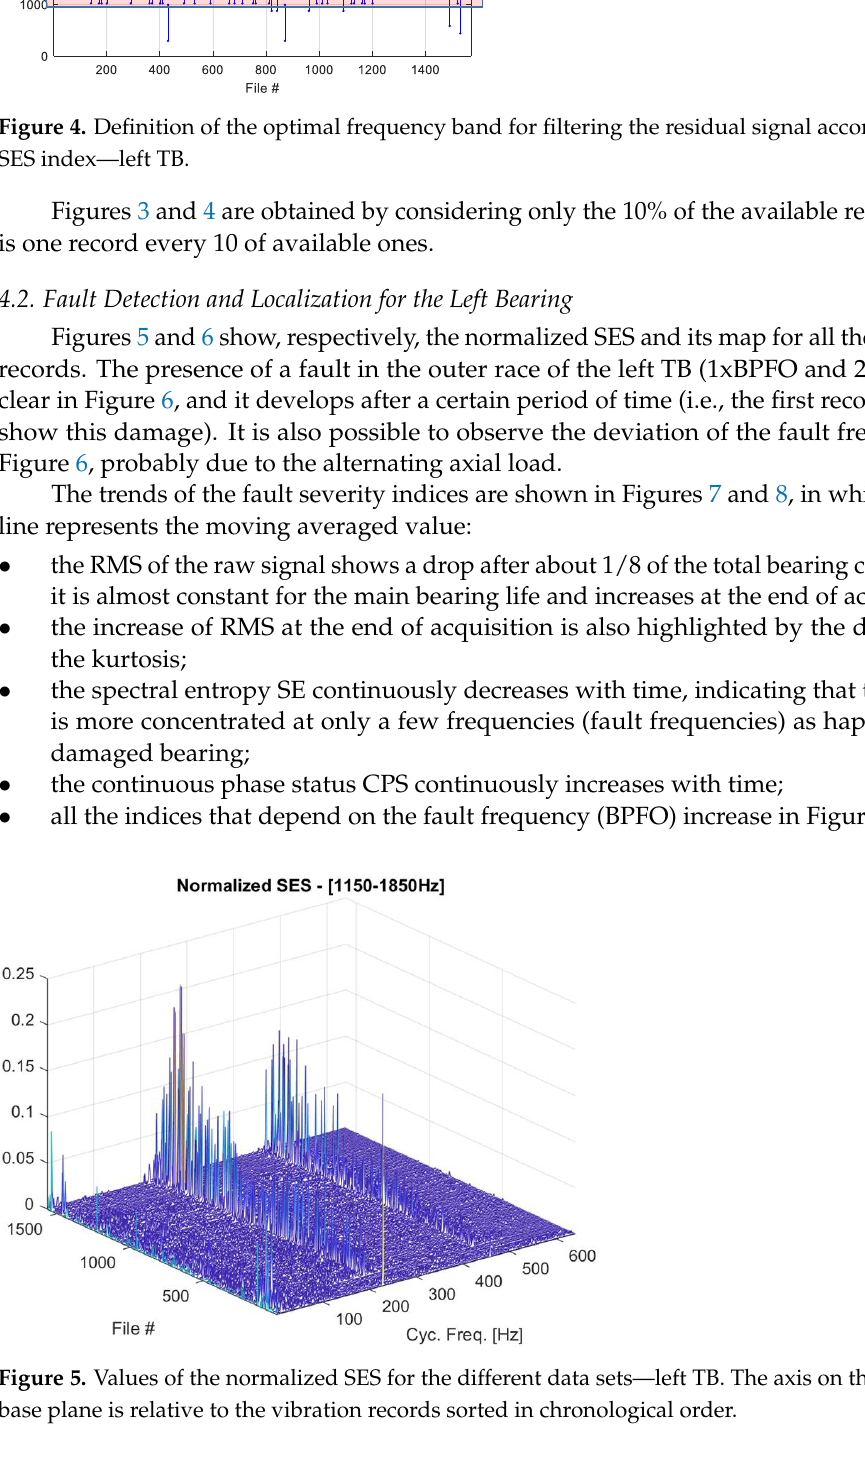
Figure 6. Normalized SES map, i.e., top view of Figure 5—left TB. The trends of the fault severity indices are shown in Figures 7 and 8, in which the red line represents the moving averaged value: 